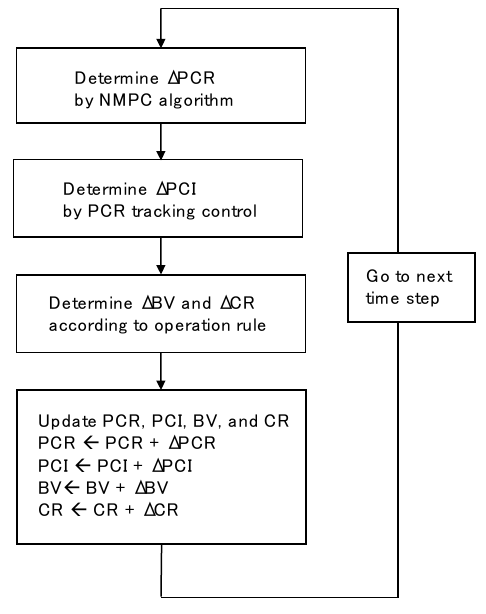
Figure 6. Flowchart of control